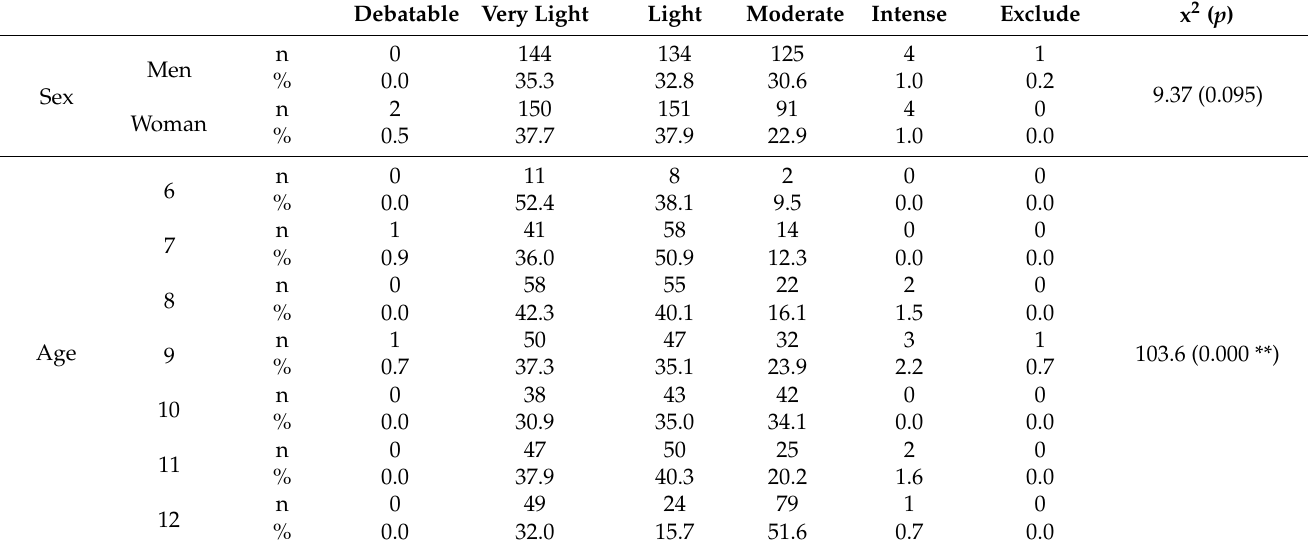
Table 3. Distribution and relationship of DF with age and